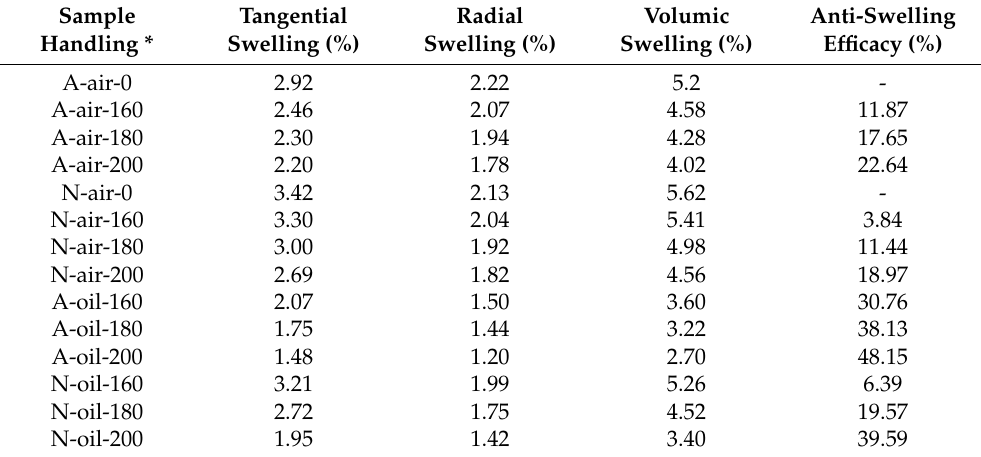
Table 4. Swelling coefficients and anti-swelling efficacy values of Afrormosia and Newtonia heat- treated under air or palm